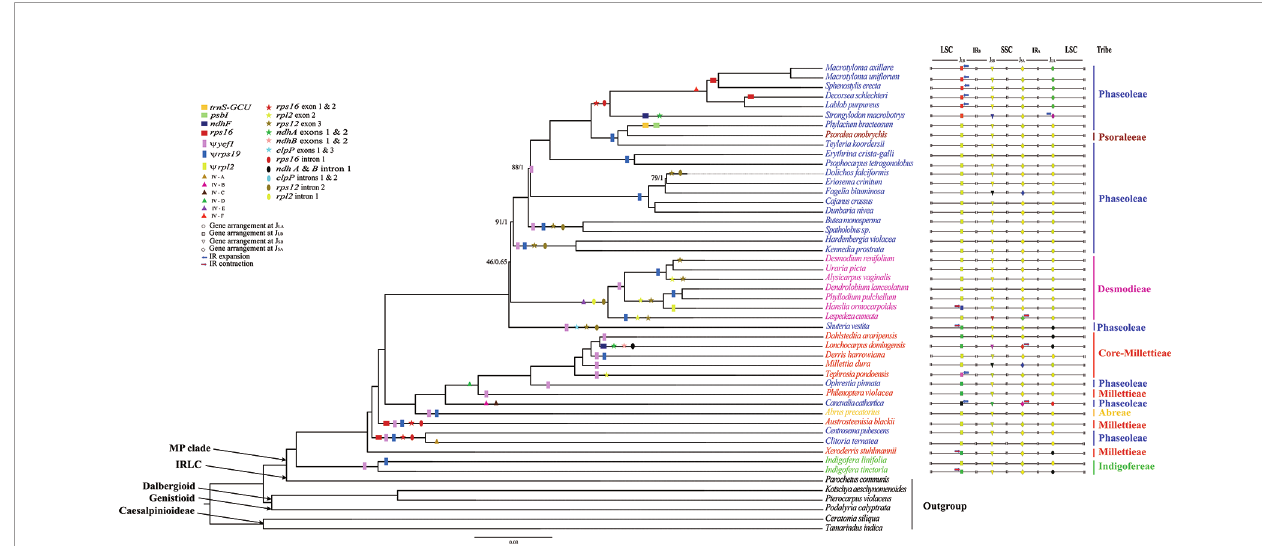
FIGURE 1 | The ML tree of the MP clade reconstructed based on the CP and the variation of IR/SC junctions. Numbers at nodes correspond to ML bootstrap percentages (only values <100% are shown) and Bayesian inference (BI) posterior probabilities (only probabilities <1.0 are shown). Genes loss, pseudogenes, inversions (IV), exon and intron loss, in the plastome, are indicated on the branches using coloured squares, rectangles, triangles, stars and oval shapes, respectively. The IR expansion and contraction are shown by blue and red arrow,